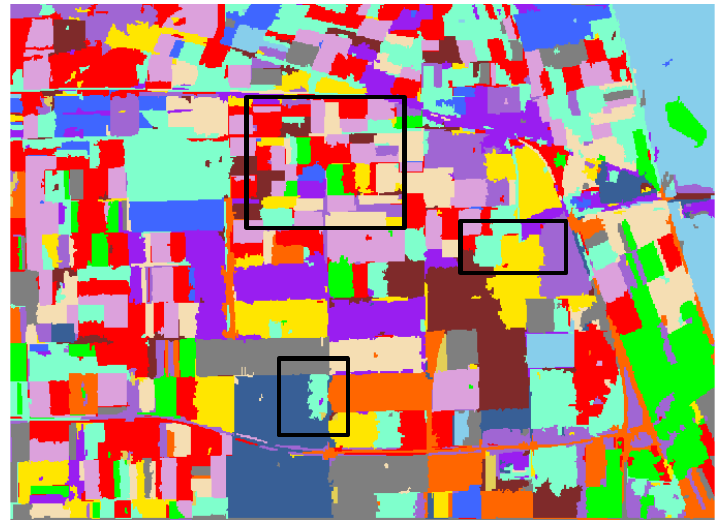
Figure 16. The classification result of the Flevoland image using the SRM algorithm.